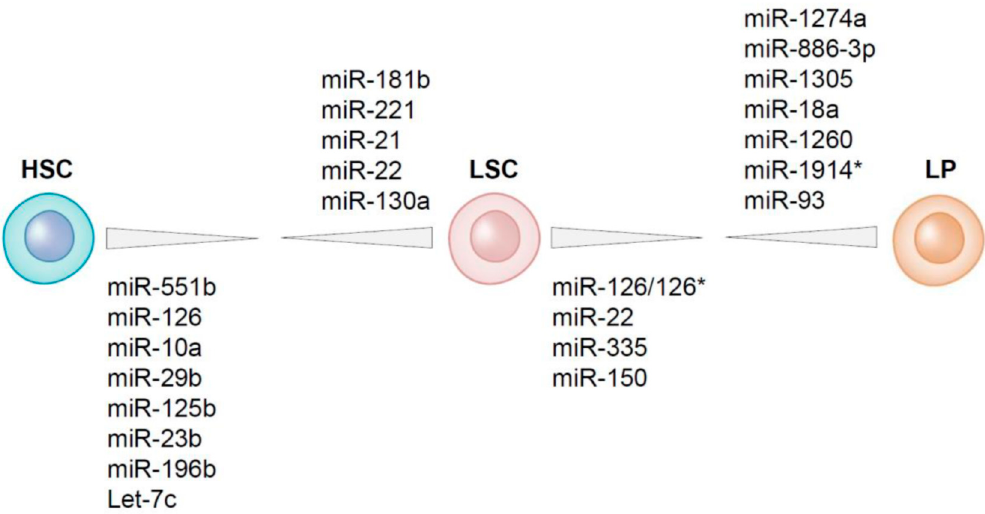
Figure 3. Differential expressed miRNAs between normal and leukemic stem cells and leukemic stem and progenitor cells obtained from AML bone marrow.